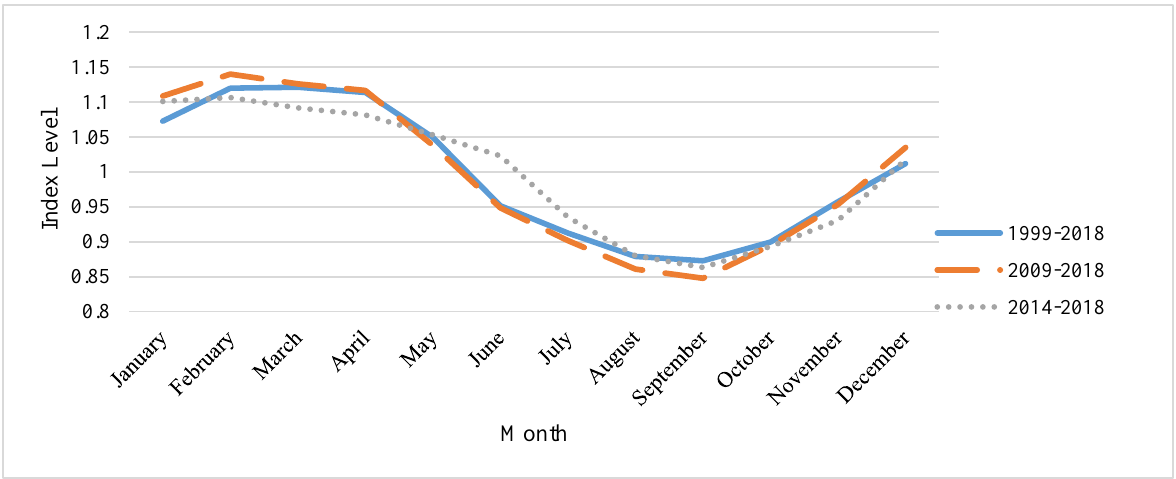
Figure 1. Monthly producer price index for the sale of 60 to 80 lb goat kids .